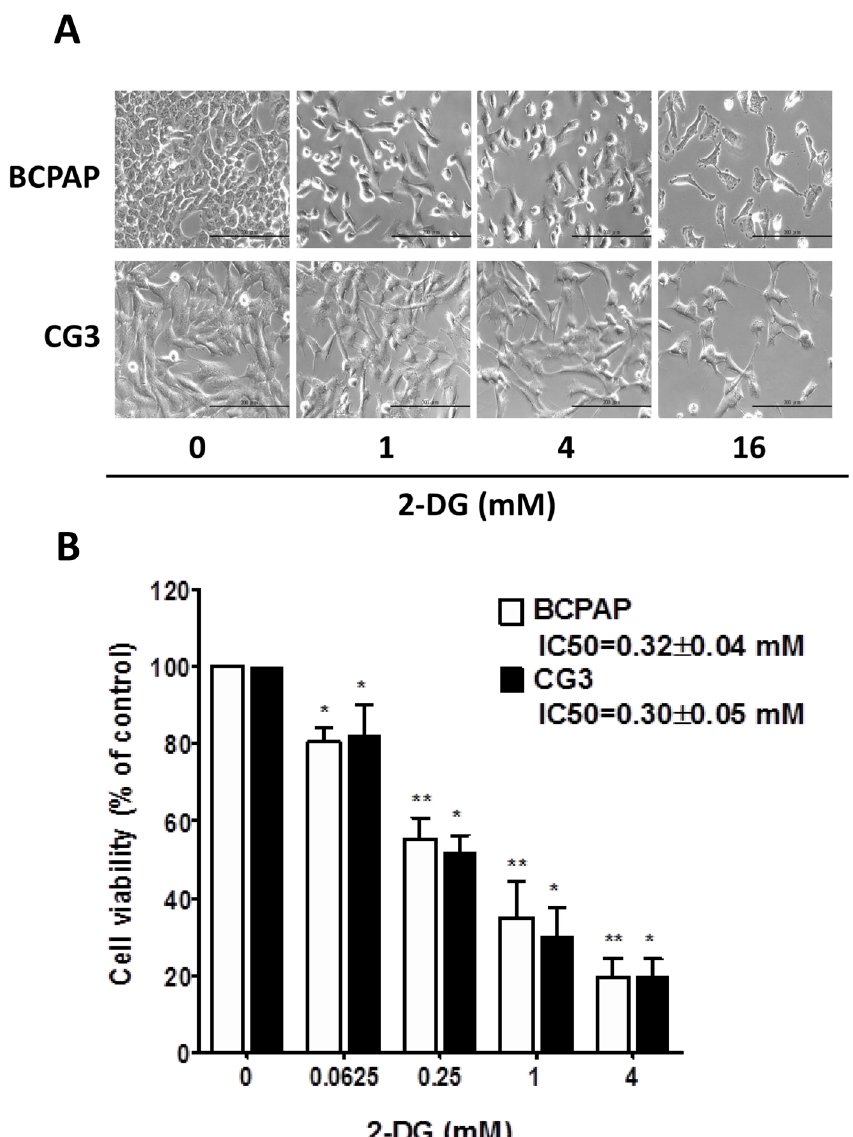
Fig 2. Susceptibility of PTC cells to 2-DG. (A) Morphological changes were observed using a microscopy (magnification: 200×). BCPAP and CG3 cells were treated for 48 h with 0, 1, 4, and 16 mM 2-deoxy- D -glucose (2-DG). (B) BCPAP and CG3 cells were treated for 48 h with 0, 0.0625, 0.25, 1, and 4 mM 2-DG. Cell viability was measured using a WST-1 assay. Data are shown as a percentage of the controls (untreated) cells. Student ’ s t test was used to compare the controls and treated cells. * p < 0.05, ** p < 0.001, compared to the controls. Data are presented as means ± standard deviation